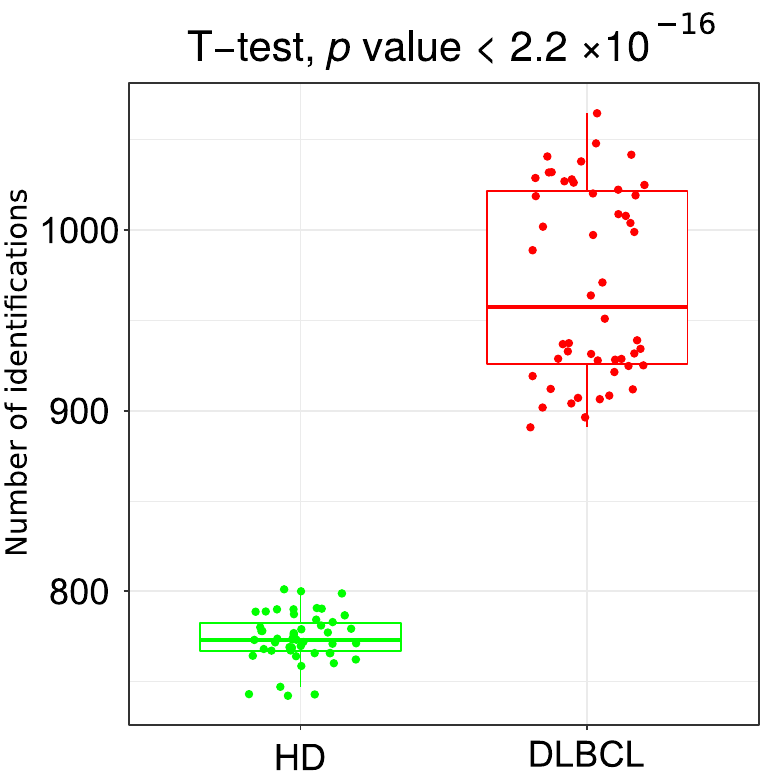
Figure A4. Boxplot of total number of gene collapsed proteins identified from 50 random subsamples of 10 DLBCL and 10 HD samples.